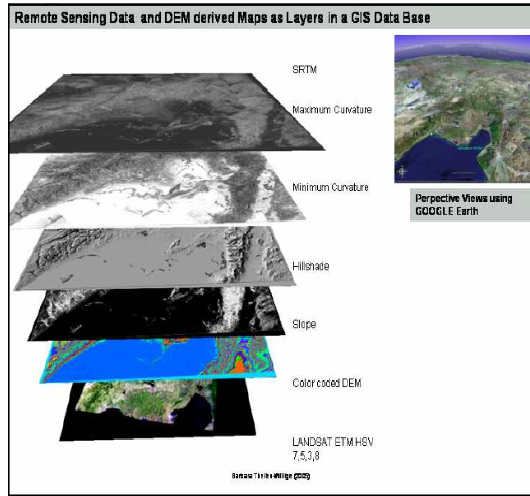
Figure 1. Remote sensing data as layers in a GIS data